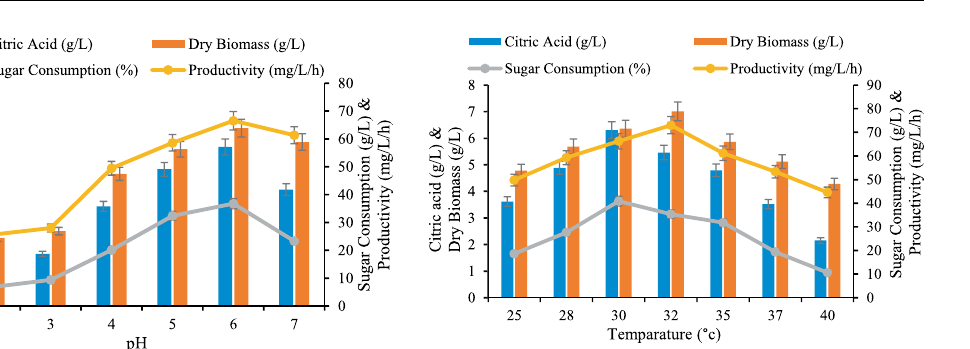
NO for production of citric 4 3